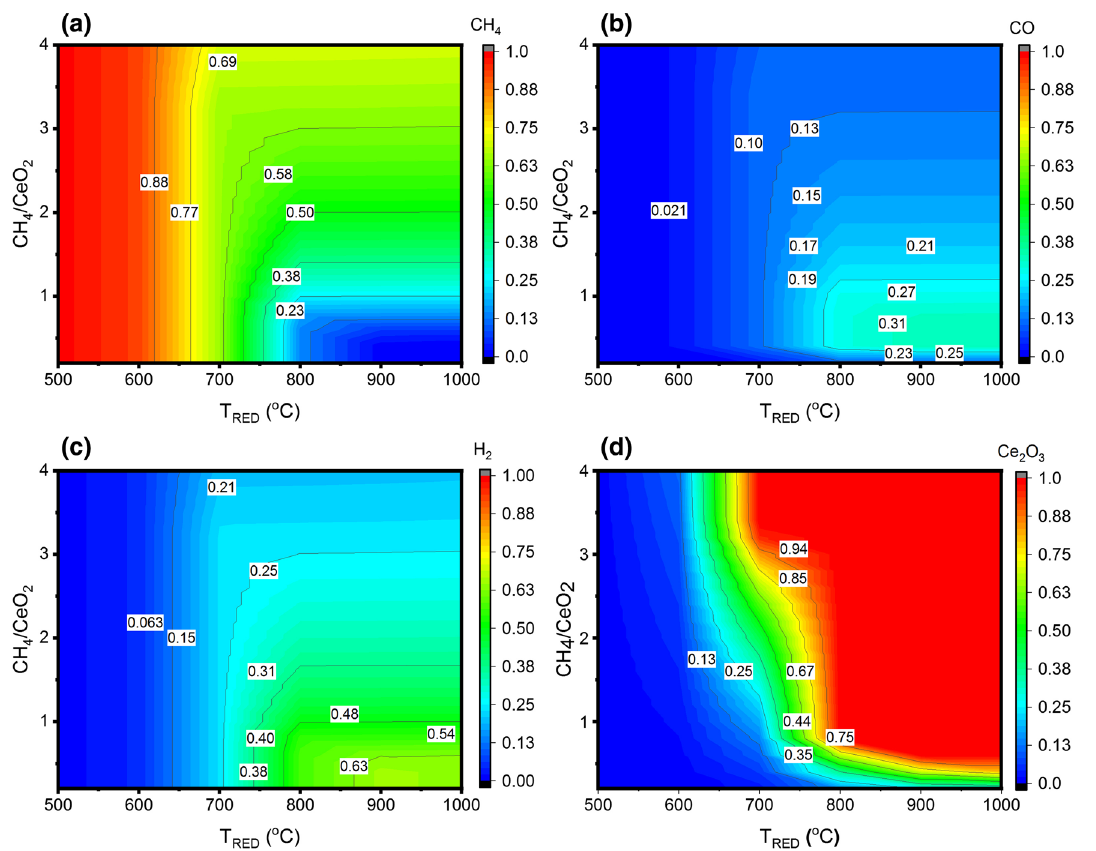
Fig. 3 Impact of the variation of the CH 4 /CeO 2 ratio and temperature on the yield of the following chemical species as molar fractions of outlet streams within the reduction reactor: a unreacted methane; b CO; c H 2 ; d Ce 2 O 3 (solids)